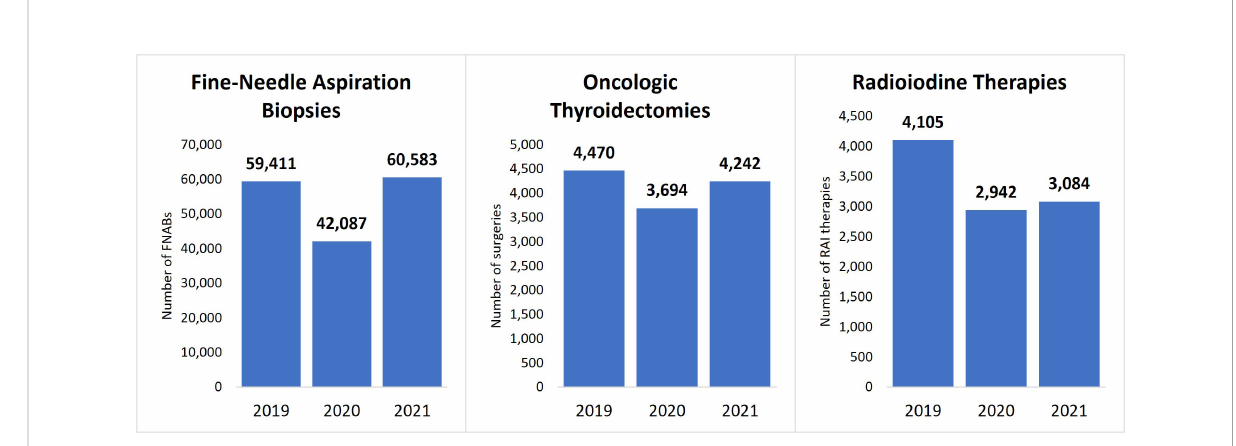
FIGURE 1 Number of procedures performed by year in Brazil ’ s public health system. FNABs, fi ne-needle aspiration biopsies; RAI, radioiodine